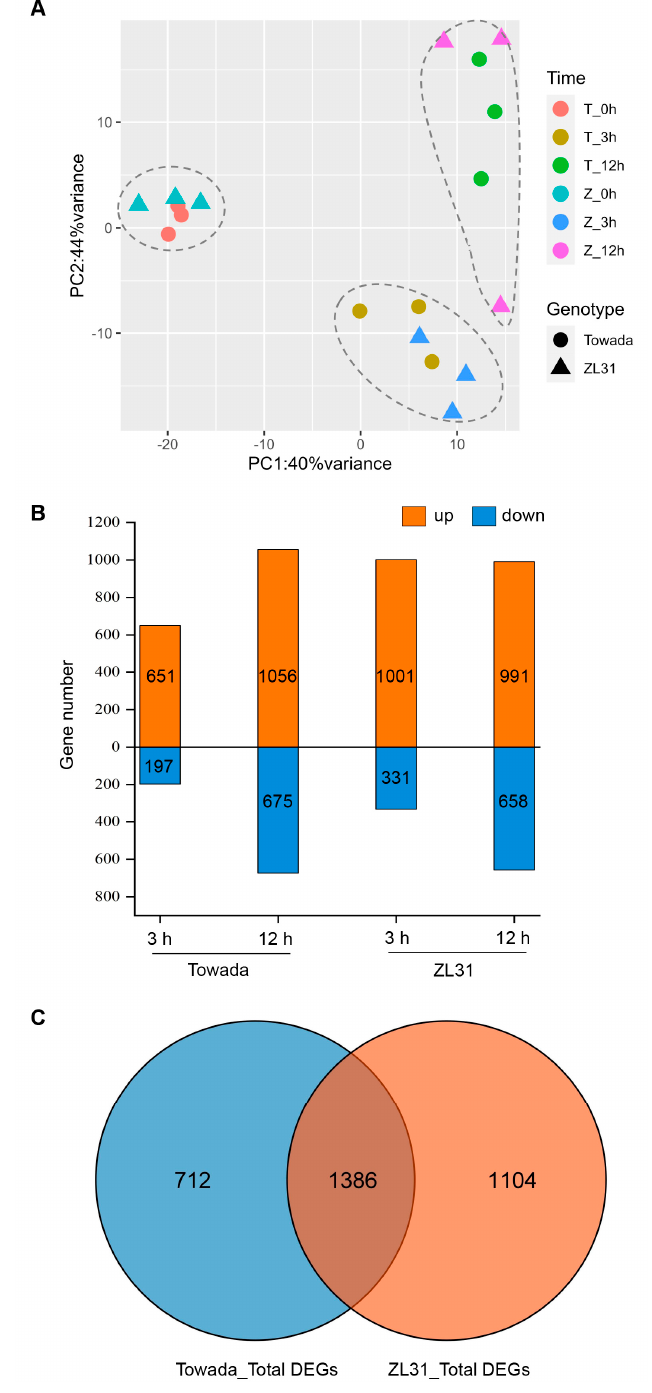
Figure 2. Overview of transcriptome data and differentially expressed genes (DEGs) in the rice response to cold stress. ( A ) Principal component analysis of the time − series transcriptome data in Towada and ZL31. ( B ) The numbers of up − and down − regulated genes in Towada and ZL31 at 3 and 12 h of cold treatment compared with the control (0 h) are shown. ( C ) Venn diagram of total DEGs in Towada compared with